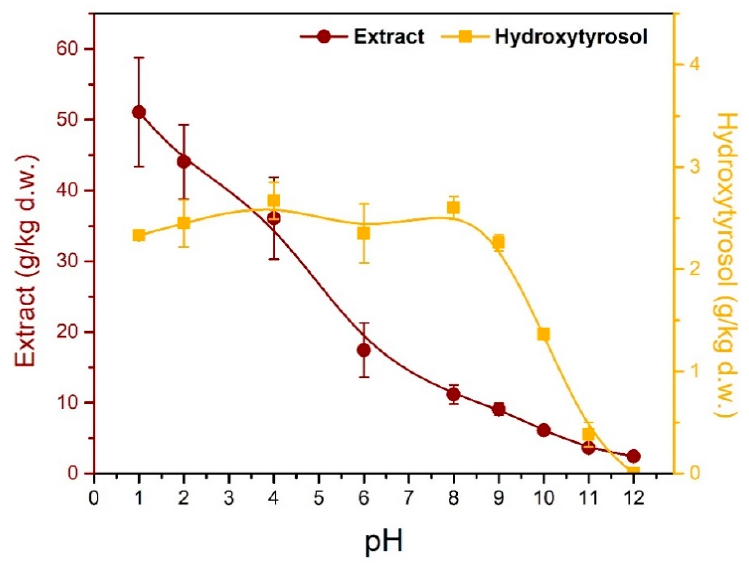
Figure 5. Effect of the pH of the aqueous phase on the quantities of total extract and hydroxytyrosol that were recovered from the organic phase, after liquid–liquid extraction.